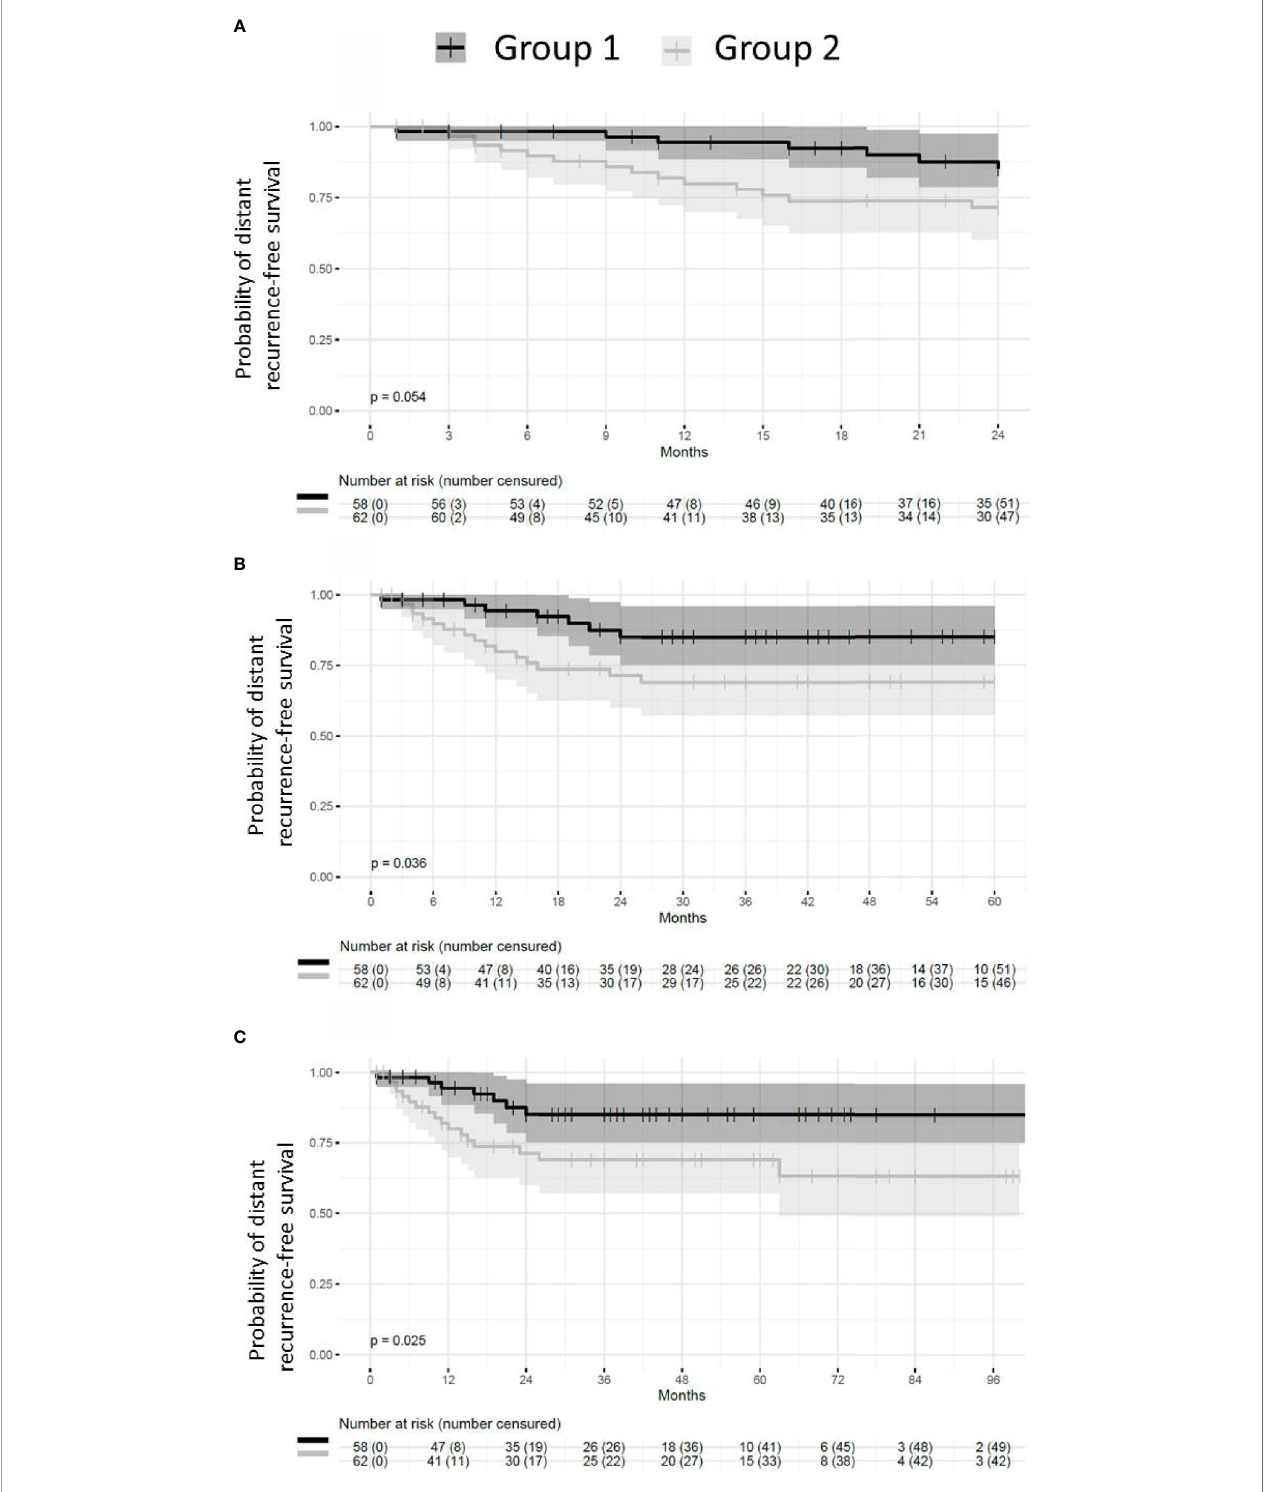
FIGURE 7 | Probability of distant recurrence-free survival from the time of surgery. Patients with pCR or small residual disease (Group 1) after neoadjuvant chemotherapy exhibit better distant recurrence-free survival (DRFS) than patients with large residual disease (Group 2). (A) DRFS from the time of surgery to 24 months (p = 0.054). (B) DRFS from the time of surgery to 60 months (p = 0.036). (C) DRFS from the time of surgery to 96 months (p =